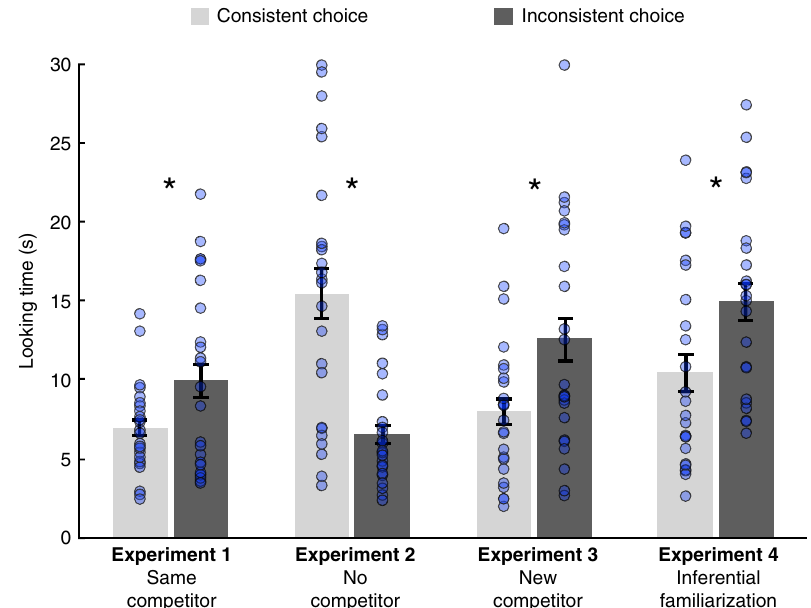
Fig. 2 Infants looking times at the agent ’ s choice in the test. Mean (±SEM) looking times (in s) in the consistent (light gray) or inconsistent choice (dark gray) conditions in the four experiments, each involving an independent group of infants ( N = 24, each). The blue dots show individual data points per participant for each experimental condition. Error bars represent the standard error of the mean. Asterisks indicate signi fi cant effects of the type of choice observed by the infants (Experiment 1: t (1, 23) = 2.5, P = 0.018; Experiment 2: t (1, 23) = 5.5, P = 0.0001; Experiment 3: t (1, 23) = 2.8, P = 0.008; Experiment 4: t (1, 23) = 2.7, P = 0.011; all tests were paired t -tests, two-tailed). Source data are provided as a Source Data fi